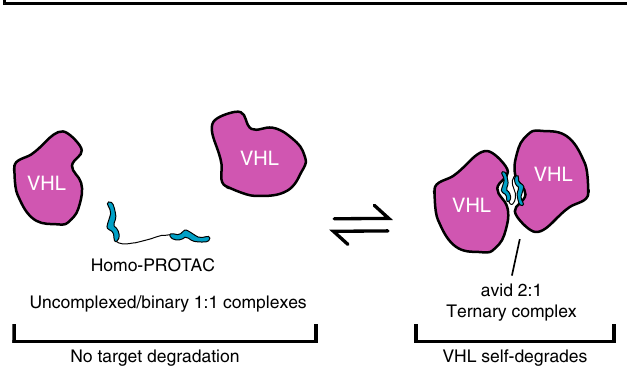
Fig. 8 Proposed model for the mechanism of action of